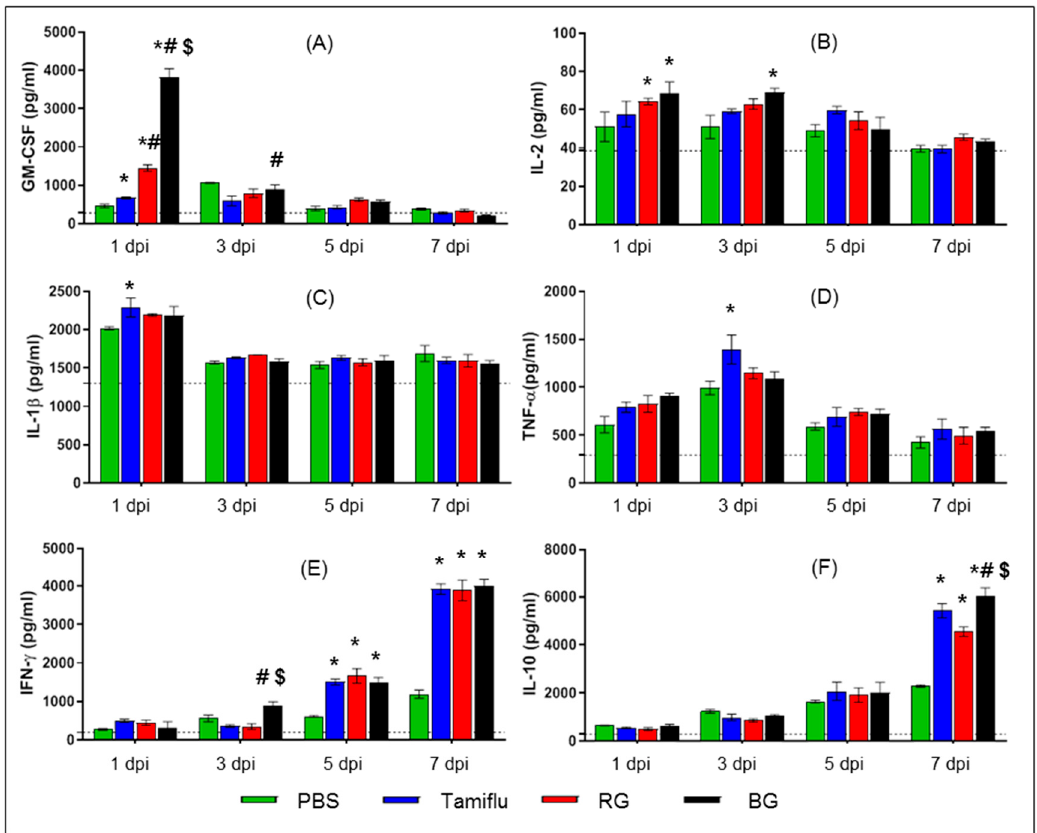
Figure 5. BG treatment further enhances production of cytokines in BALF. At 1, 3, 5, and 7 dpi BALF samples were harvested from PBS-, Tamiflu-, RG-, and BG- treated mouse lungs. Bronchoalveolar lavage fluid (BALF) samples were also isolated from uninfected mice for use as an intact control (dotted line). Cytokine production was analyzed in lung BALF by BioPlex analysis. ( A ) Granulocyte-macrophage colony-stimulating factor (GM-CSF), ( B ) Interleukin 2 (IL-2), ( C ) IL-1 β , ( D ) tumor necrosis factor-alpha (TNF- α ), ( E ) interferon-gamma (IFN- γ ), and ( F ) IL-10. Values are the mean (n = 6 per group at each time point) ± SEM. *, p < 0.05 vs. PBS; #, p < 0.05 vs. Tamiflu; $, p < 0.05 vs.